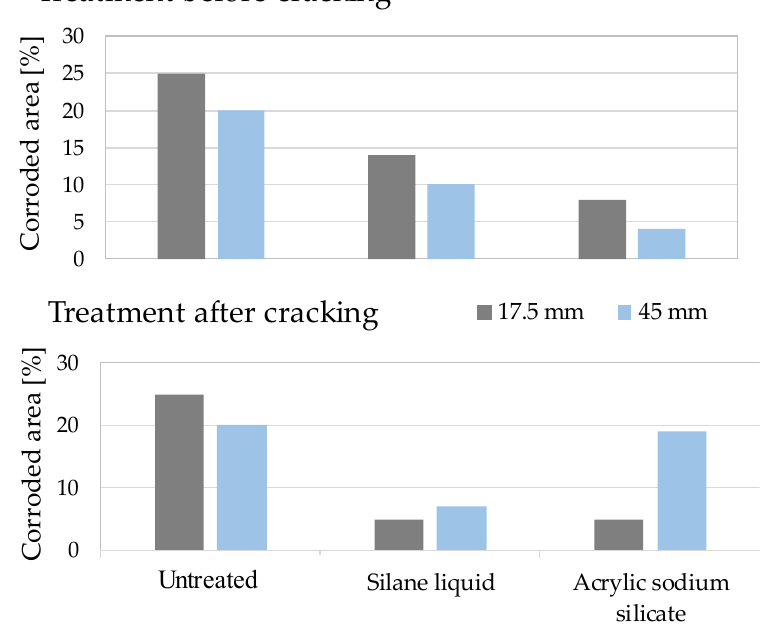
Figure 22. Influence of cover thickness and surface treatment on the corrosion of internal steel, adapted from [34].